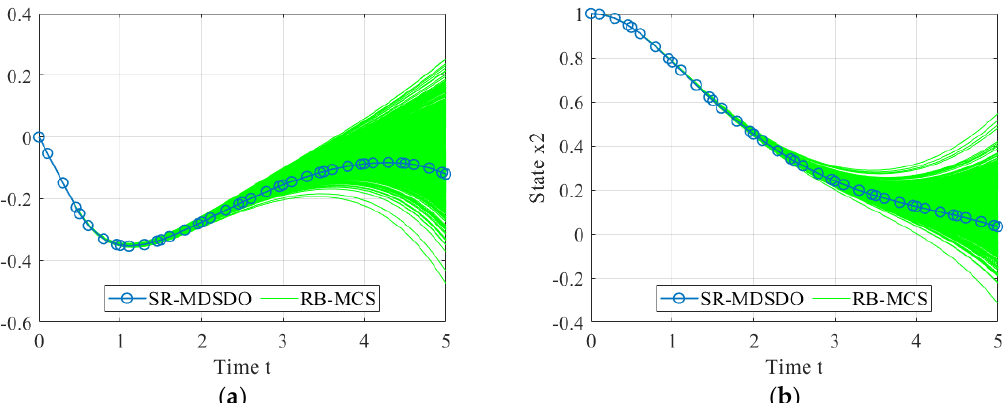
Figure 7. The uncertainty influence on state trajectories under C-MDSDO. ( a ) State trajectories of x 1 . ( b ) State trajectories of x 2 .